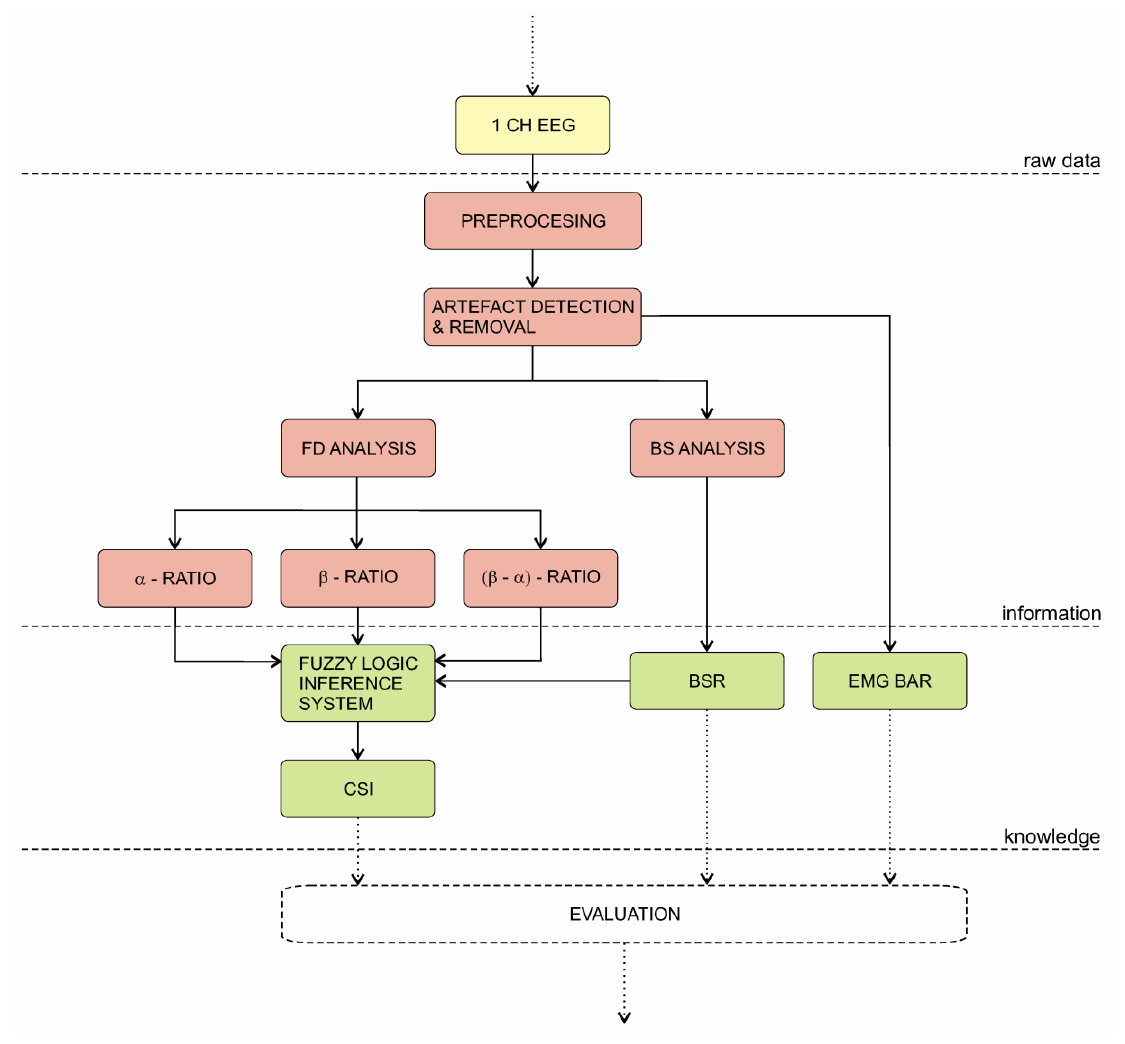
Figure 10. Block diagram of the algorithm of the CS Monitor Abbreviations: BS (burst suppression), BSR (burst suppression ratio), FD (frequency domain), electromyogram activity (EMG), CSI (cerebral state